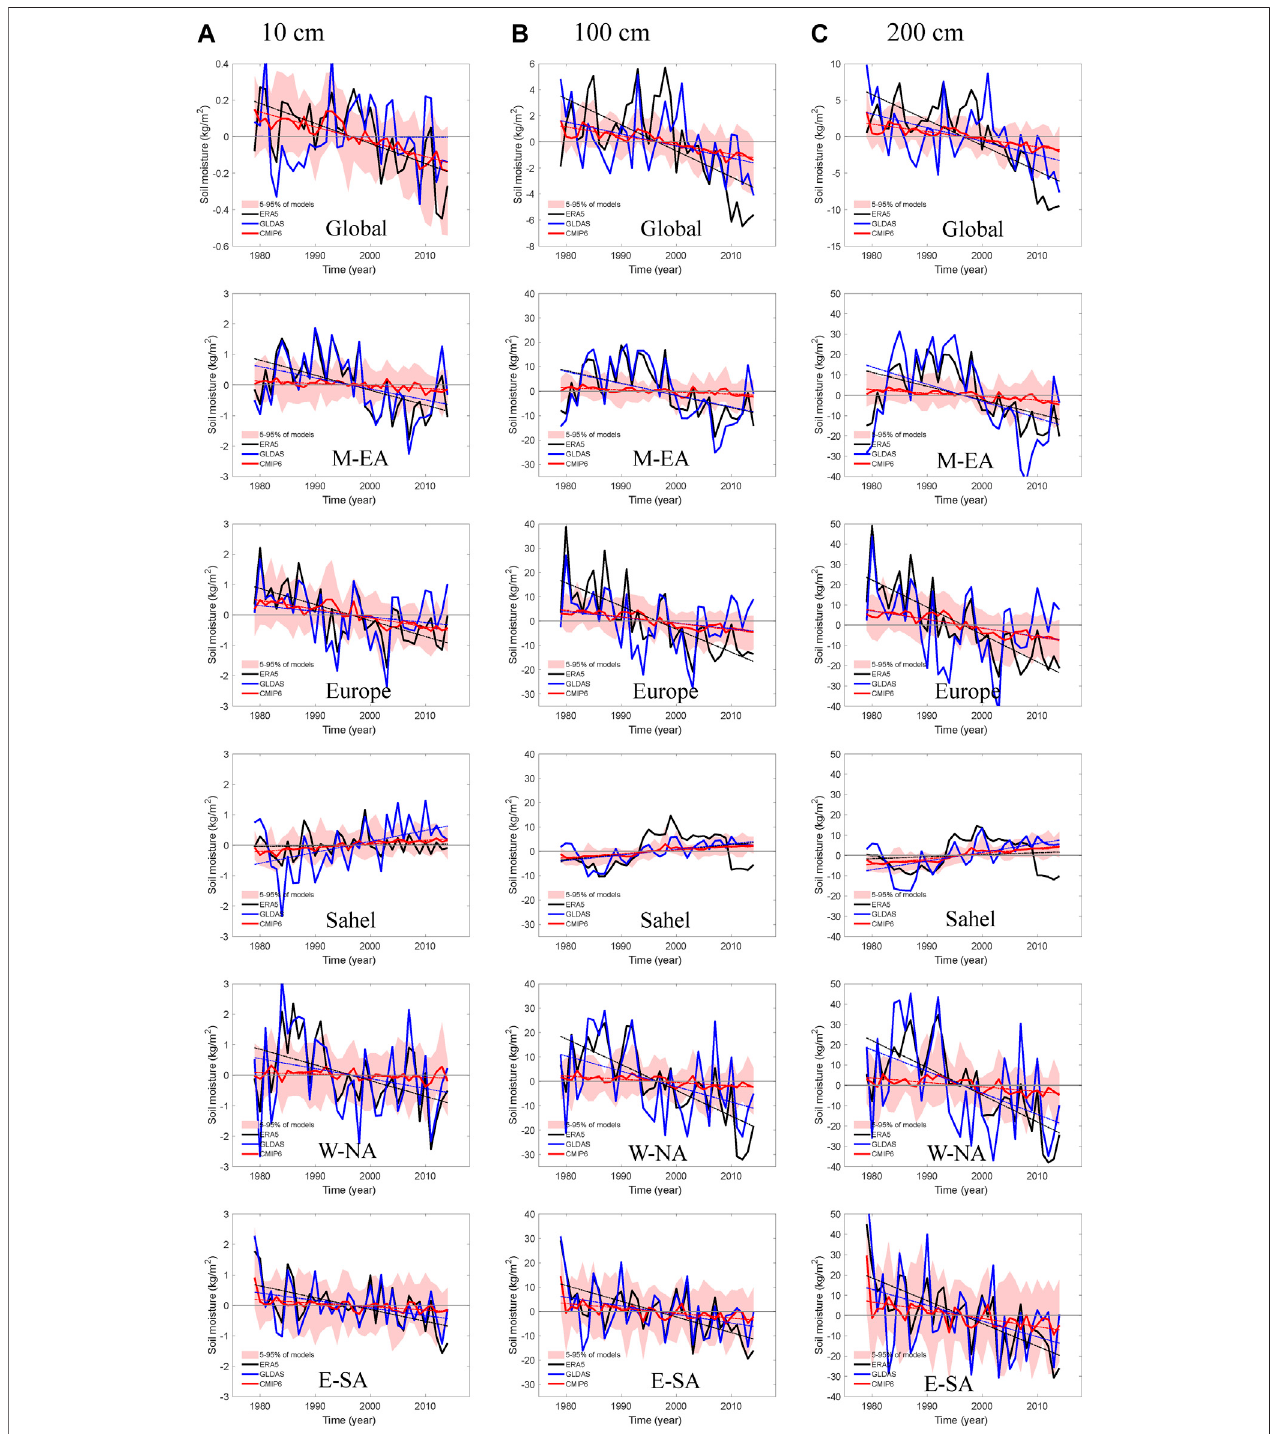
FIGURE3| Time series ofsoilmoisture (kg/m 2 , 1979 – 2014) intheglobal average and selectedhotspots. Thesolidblack lineisERA5,thesolidblue lineisGLDAS, the solid red line is CMIP6-MMEM, the corresponding dotted line is the trend line, and the pink shade is the range of 5 – 95% of all CMIP6 models. The M-EA is mid- latitudes of East Asia, the W-NA is Western North America, and the E-SA is Eastern South America.